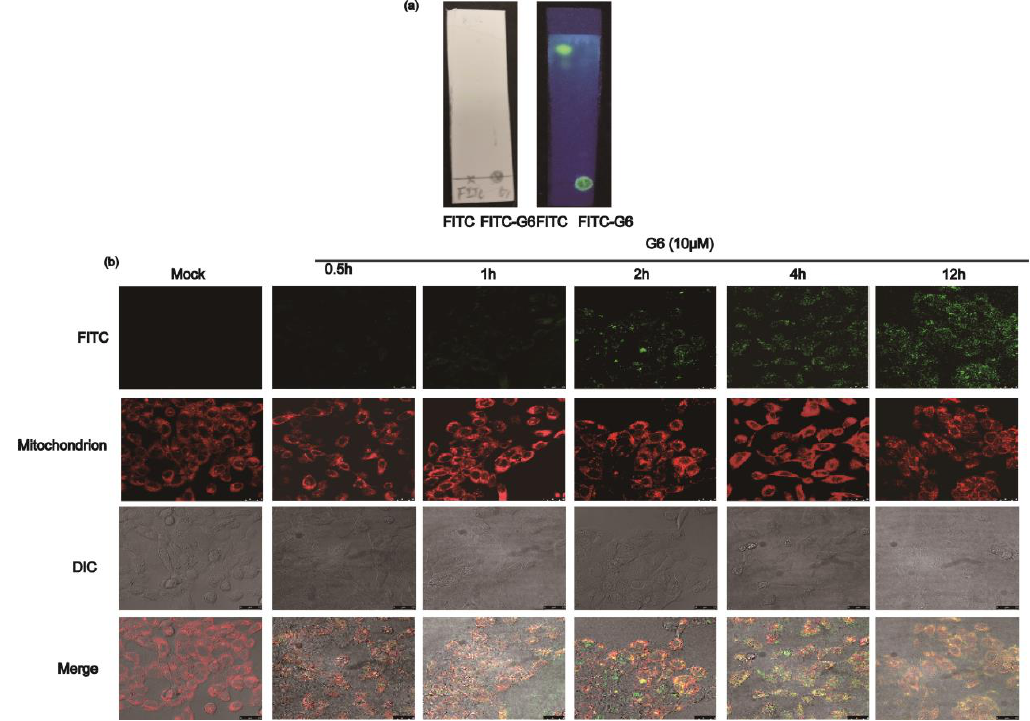
Figure 4. G6 localizes to the mitochondria. ( a ) Thin-layer chromatography results of FITC labeled G6; ( b ) laser-scanning confocal microscopy images of HaCaT cells incubated with MitoTracker Red CMXRos (100×) and FITC-G6. Red fluorescence from MitoTracker Red CMXRos and green fluorescence from FITC-labeled G6, and orange-yellow fluorescence from these two merged sources of fluorescence.